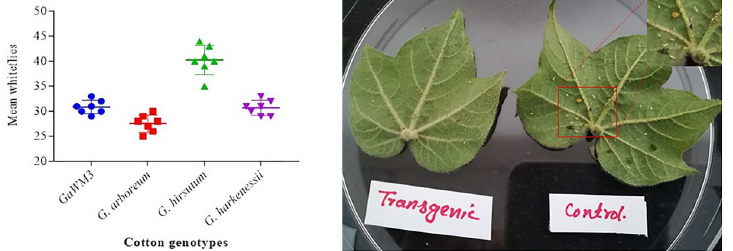
Fig 7. (A) Number of whiteflies visits to different genotypes of cotton (B) The trend of whitefly both on transgenic and control cotton ( G . hirsutum ) plants.